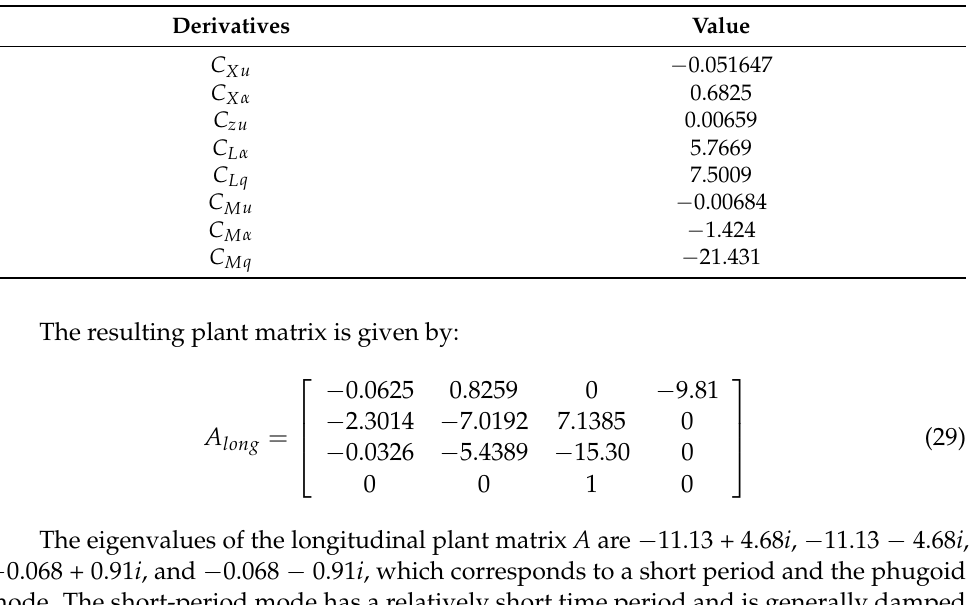
Table 7. Longitudinal derivatives of aerodynamic coefficients.